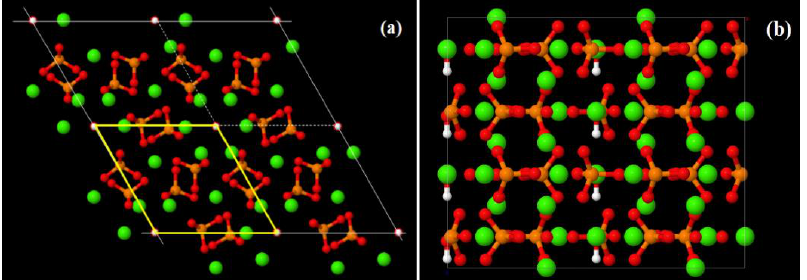
Figure 2. Super-cell 2 × 2 × 2 = 8 HAP unit cell model: ( a ) in c -axis projection — perpendicular to OH-channel (see in center), the unit cell is shown by yellow lines; ( b ) in b-axis projection—the OH groups in vertical line positions for the P6 3 phase.